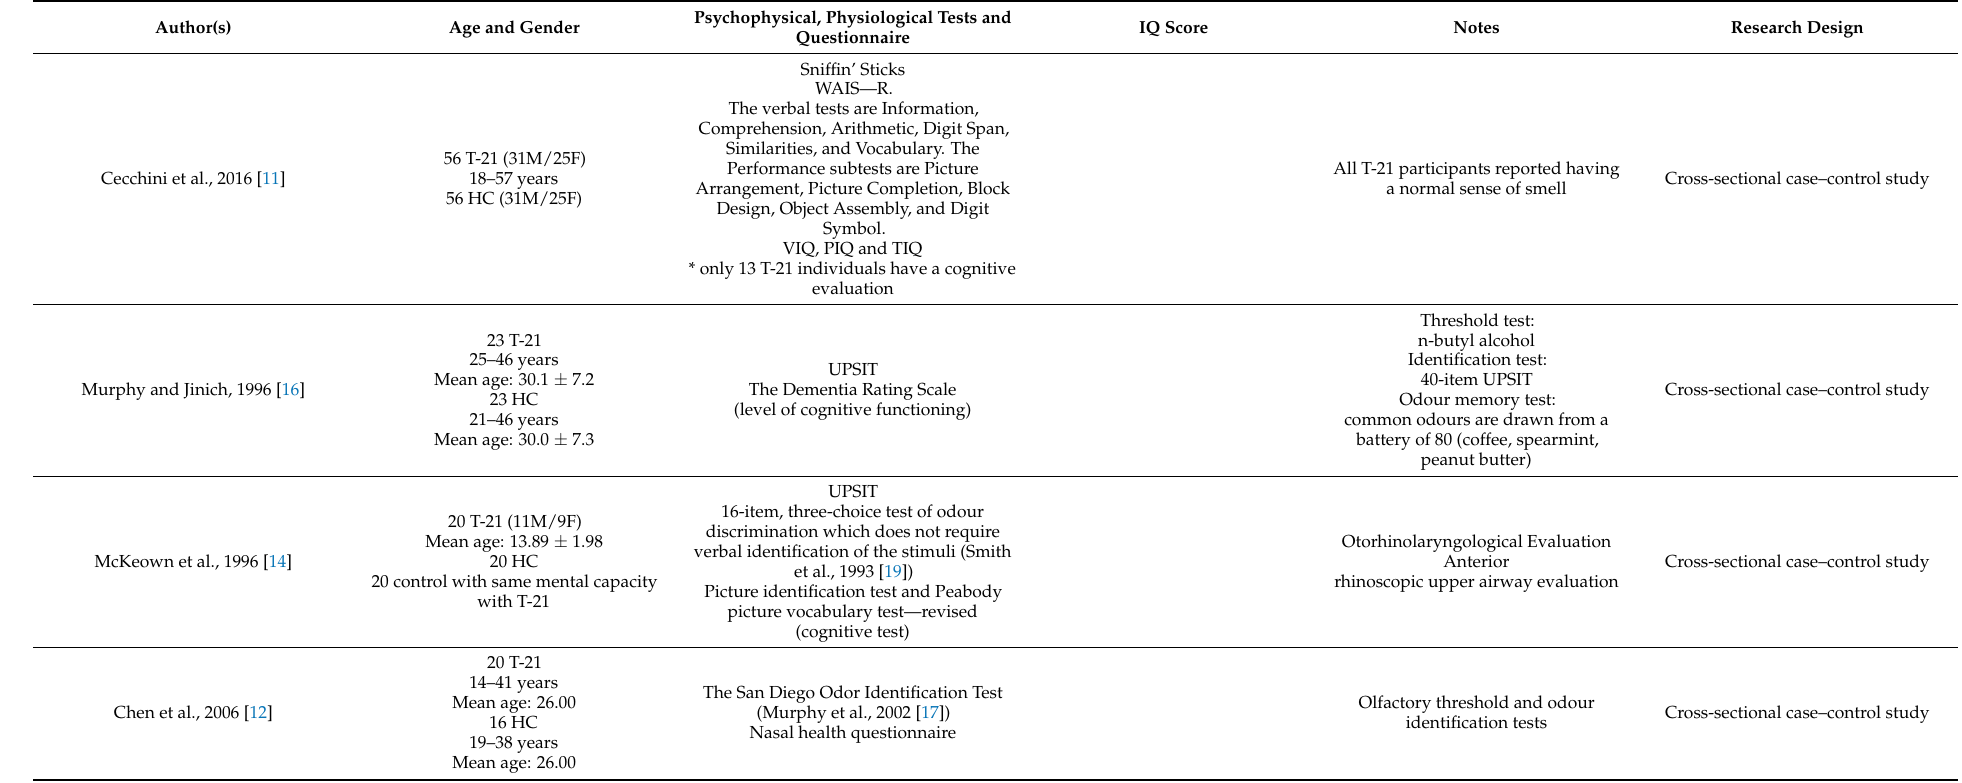
Table 1. Studies of the olfactory system and individual with trisomy 21: demographic information, clinical characteristics, and associated